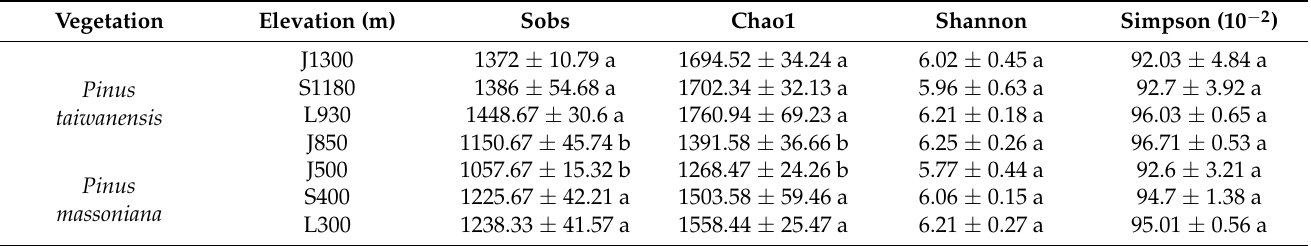
Table A2. Alpha diversity of fungal diversity in Pinus taiwanensi and Pinus massoniana forests soils with the